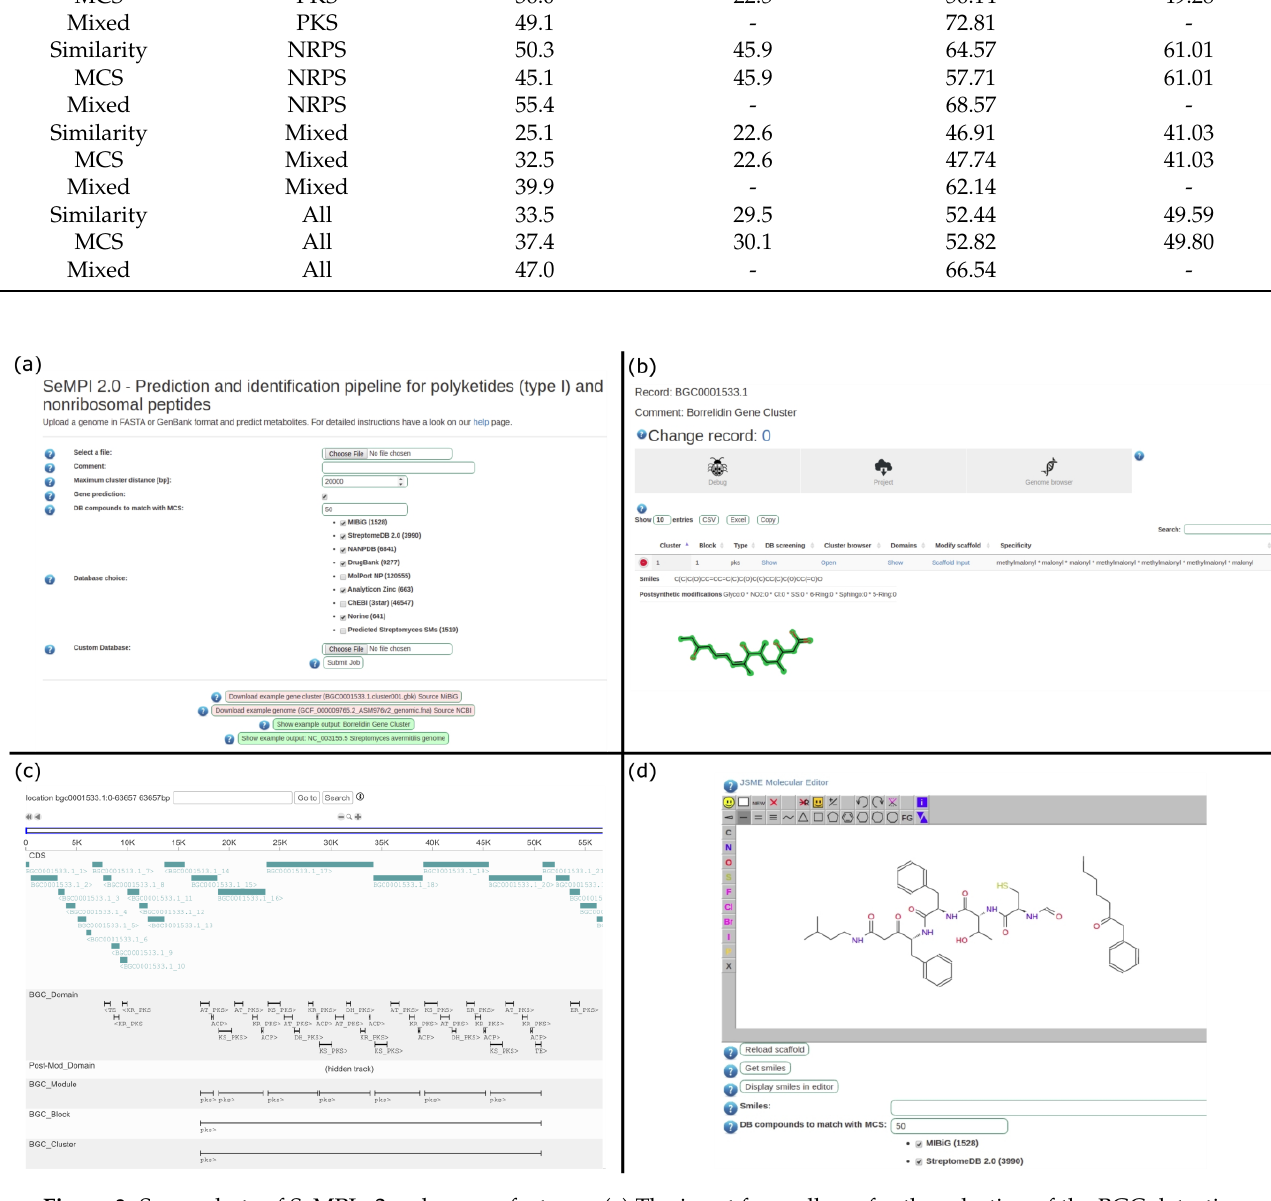
Figure 3. Screenshots of SeMPI v2 web server features. ( a ) The input form allows for the selection of the BGC detection